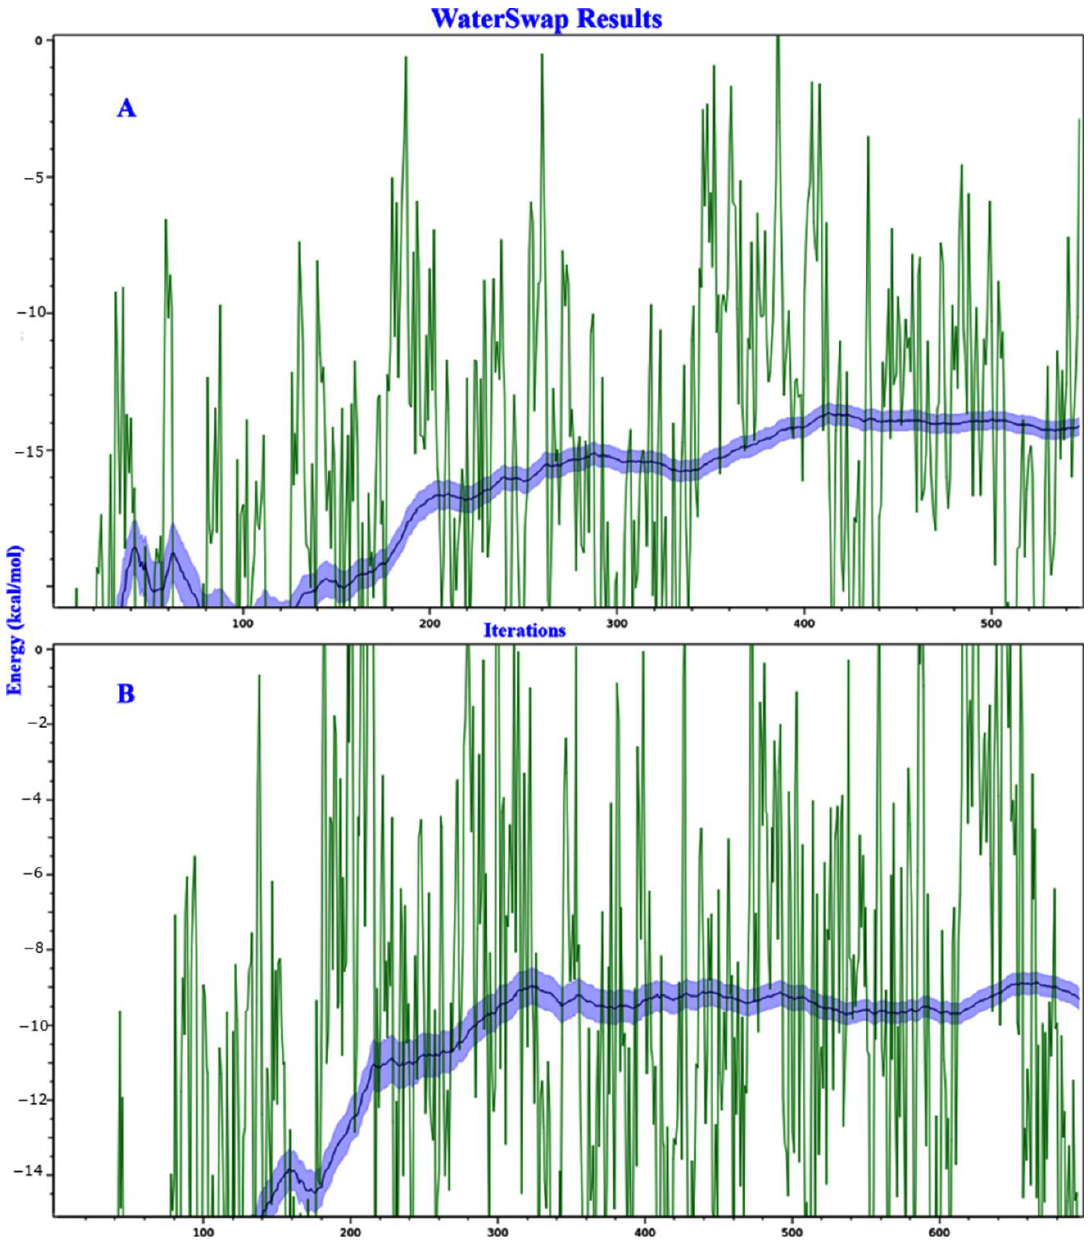
Figure 8. Water Swap results of myricetin ( A ) and quercetin ( B ).